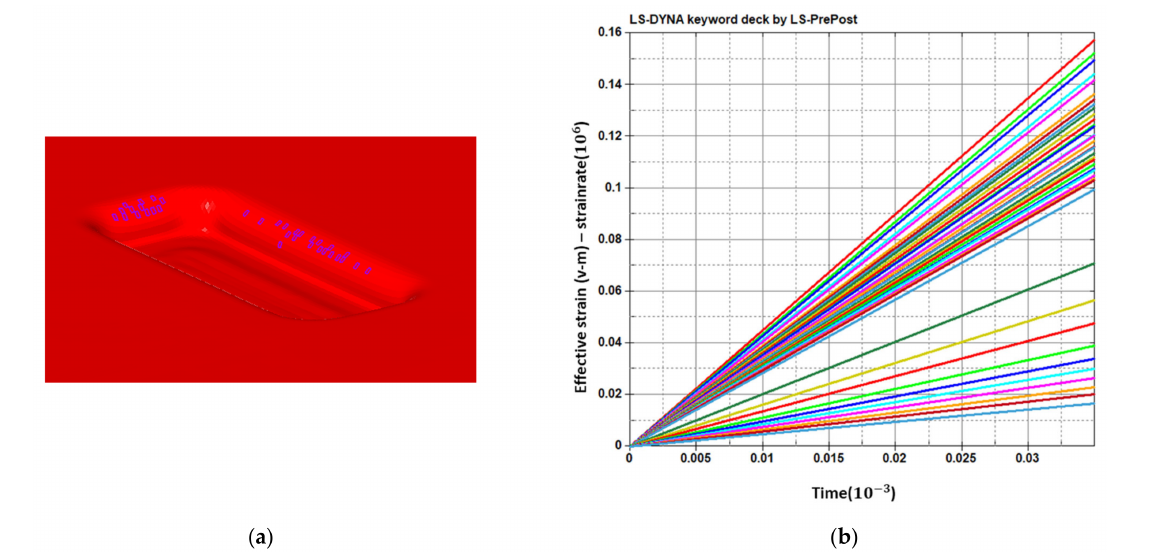
Figure 7. Strain rate for elements of die R area ( a ) randomly selected elements in die R region, and ( b ) strain rate of selected